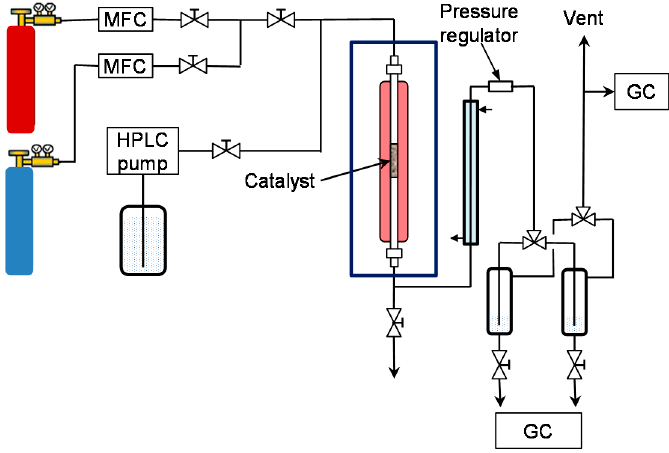
Figure 9. Schematic setup of the continuous fixed bed reactor.